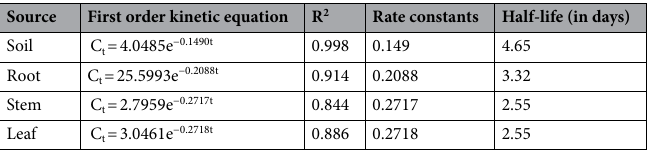
Table 1. The half-life of spinetoram in the soil and different parts of the flowering